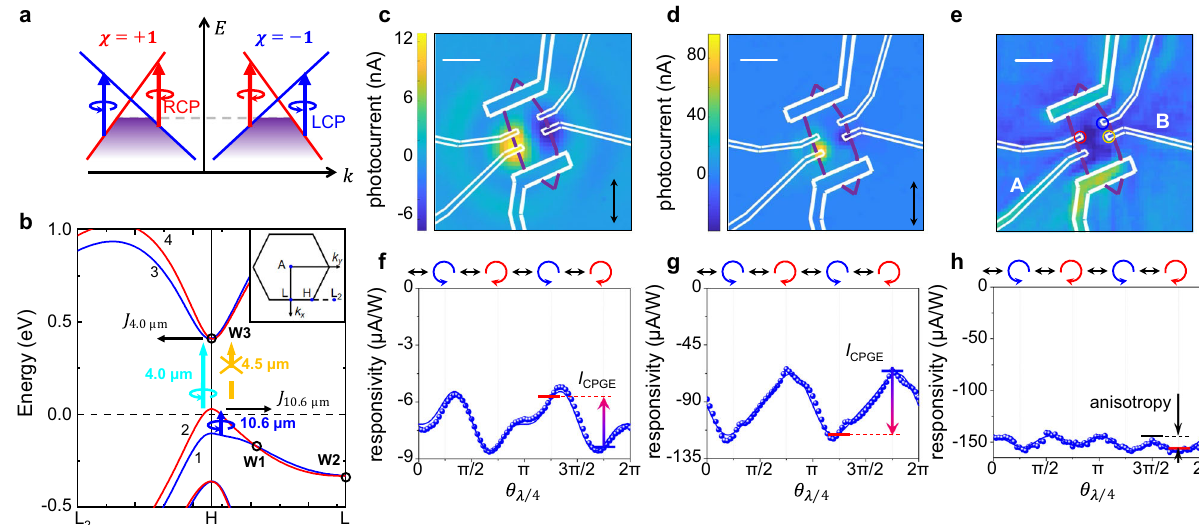
Fig. 2 | Contrasting circular-polarization-dependent photoresponse of Te under different mid-infrared wavelength excitations. a A schematic diagram of opticalselectionrulesatthevicinityofapairofWeylnodeswithoppositechirality. ThegraydashlinemarkstheFermilevel. b ThebanddiagramneartheHpointofTe taking spin-orbit interaction into consideration. The blue, cyan, and yellow arrows denote to transitions induced by 10.6 μ m, 4.0- μ m and 4.5- μ m excitations, respec- tively.W1,W2,andW3marksthreeWeylnodesnearHpoint.Energybandsforming W1 and W3 are marked by 1 – 4. Inset shows Brillouin zone with L, H, and L 2 points. c , d Scanning photocurrent images of the Te device under 10.6- μ m and 4.0- μ m excitation, respectively. Double-arrows denote to the direction of excitation light